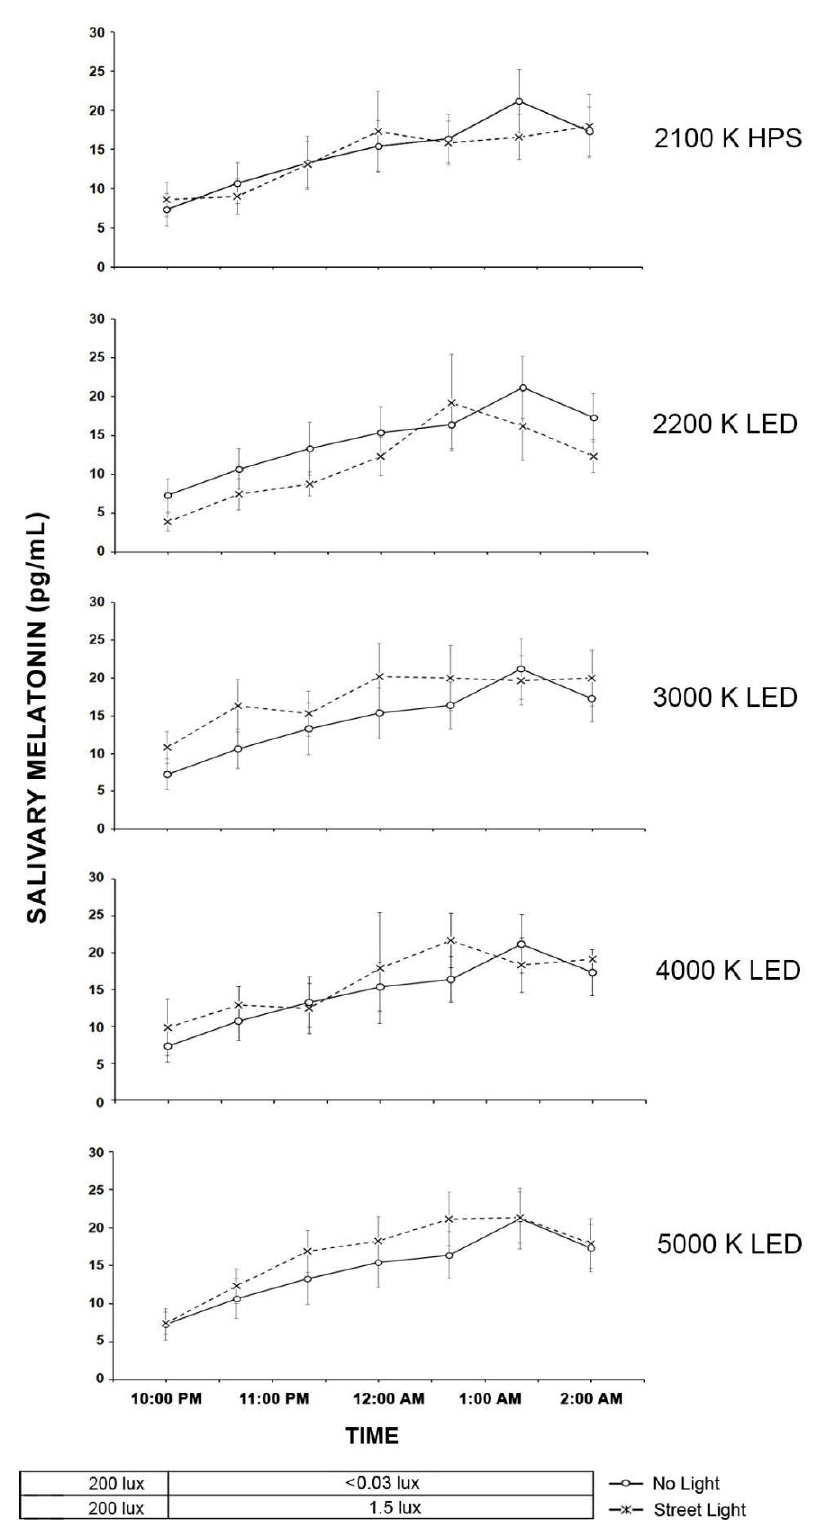
Figure 9. In the five graphs above, each of the roadway lighting conditions is compared to no roadway lighting for their effects on salivary melatonin of pedestrian participants. The “O” symbols represent the mean salivary melatonin levels during the no roadway lighting condition ( ± SEM). The “X” symbols represent the mean salivary melatonin levels during exposure to roadway lighting (+SEM). The 10 lx illuminance value (1.46–5.7 melanopic EDI) for pedestrian lighting conditions from IESNA RP-18-14